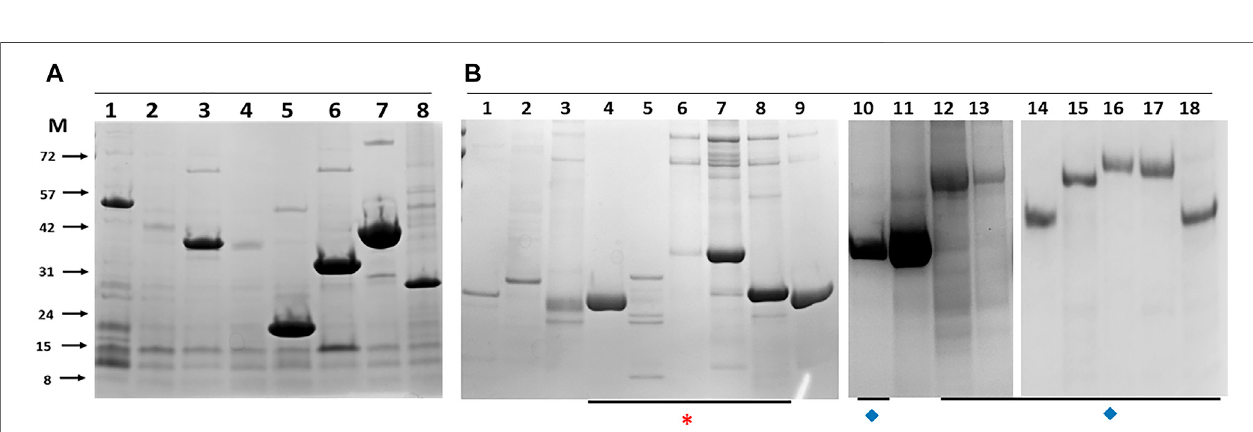
FIGURE 2 | Example Western blot detection of recombinant M. bovis proteins with anti-His antibody. Panel (A) . Detection of M. bovis ORFs expressed in induced E.coli .Thelaneidentityand predicted molecular massare: 1-Mb1228 (39 kDa),2-Mb1916(18 kDa), 3-Mb2410(15 kDa), 4-Mb3441 (11 kDa), 5-Mb3412c (34 kDa),6- EsxRST (32 kDa), 7-EsxNOQ (30 kDa), 8-EsxU (24 kDa), 9-EsxFDE (27 kDa), 10-EsxAB (21.2 kDa). Panel (B) . Detection of M. bovis ORFs expressed in baculovirus infected insect cells. The lane identity and predicted molecular mass are: 1-PPE15_PE8 (66 kDa), 2-PPE20_PE15 (67 kDa), 3-PPE31_PE20 (51 kDa), 4- PPE41_PE25 (34 kDa), 5-PPE60_PE31 (53 kDa), 6-MTRA (28 kDa), 7-PPE14_PE7 (53 kDa), 8- Mb0463_Mb0674 (59 kDa), 9-Mb0854_Mb0977 (63 kDa), 10- Mb1036_Mb1129c (74 kDa), 11-Mb1272_Mb2477c (54 kDa), 12-Mb0891c (34 kDa), 13- Mb3070_Mb3641 (54 kDa), 14-Mb3338_Mb3644c (54 kDa). Open square ( □ ) symbols indicate protein which show some breakdown as indicated by at least 2 His antibody reactive bands. Asterisk (*) indicates all Esx related proteins, most as concatenates.Diamonds( ◆ )indicateconcatenatedPPE-PE pairs.Circles ( R )otherproteinconcatenates.Mindicatesthemarkertrack, themolecularmassesofwhich are given on the left of panel (A) in